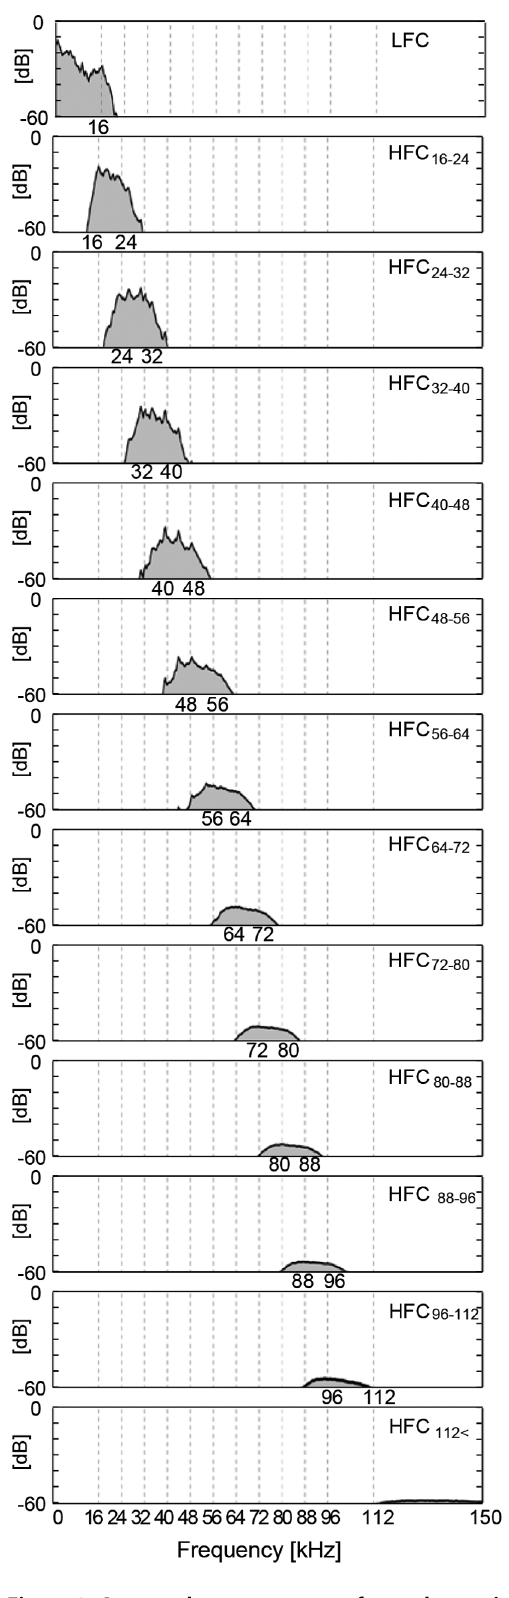
Figure 3. Averaged power spectra of sound materials applied in Experiment 2. Filtered electric signals of LFC under 16 kHz (control) and HFCs above 16 kHz. Frequency from 16 kHz to 96 kHz was divided into ten bandwidth components at every 8 kHz, while